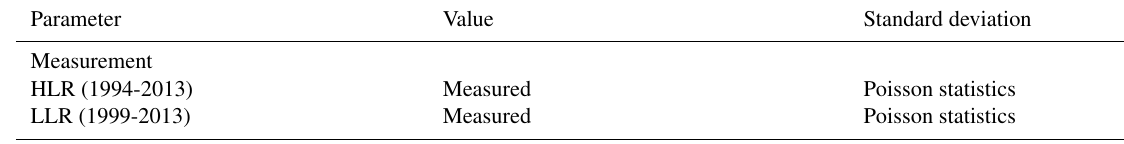
Table 3. Values and associated uncertainties of the measurements and the a priori, retrieval, and forward model parameters Parameter Value Standard deviation Measurement